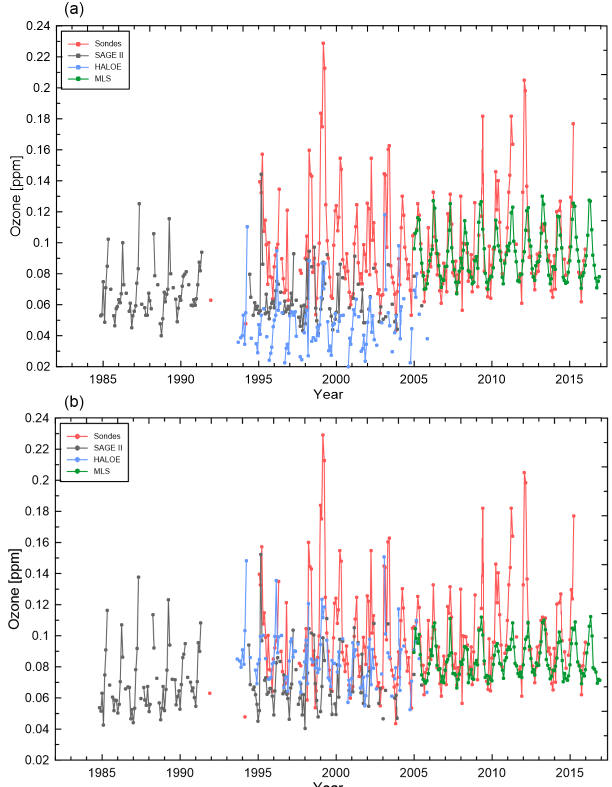
Figure 3. Monthly mean zonal mean ozone mixing ratios from dif- ferent data sources (color coded as shown in the legends) at 182hPa between 25 and 30 ◦ N. (a) Unadjusted time series and (b) adjusted, bias-corrected time series. The standard to which the measurements were adjusted to are the ozonesonde measurements at this level. For more details see